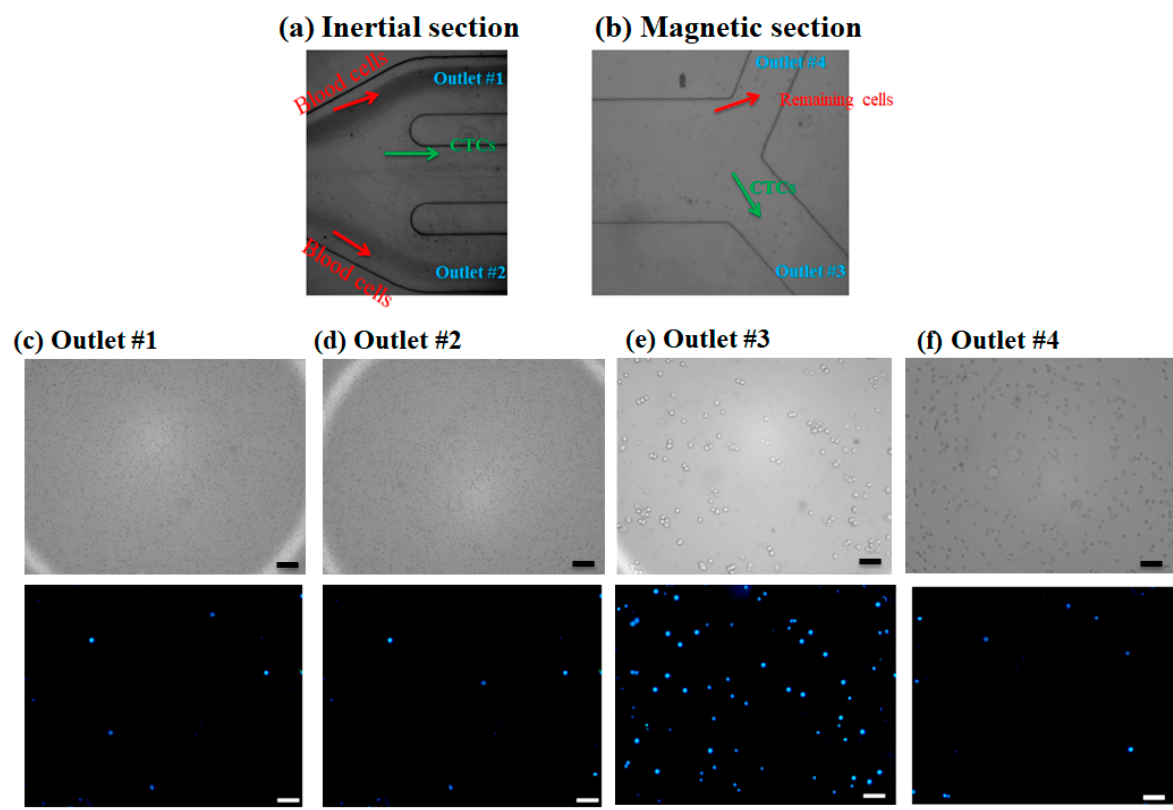
Figure 5. ( a , b ) Microscopic images for cell suspension flow at the outlet of inertial and magnetic separation, respectively. ( c – f ) Brightfield image and DAPI stained image for MCF-7 cells in different collecting outlets in inertial and magnetic separator. Scale bares are 100 µm.